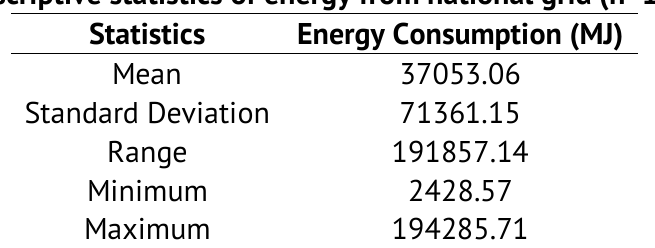
Descriptive statistics of energy from national grid